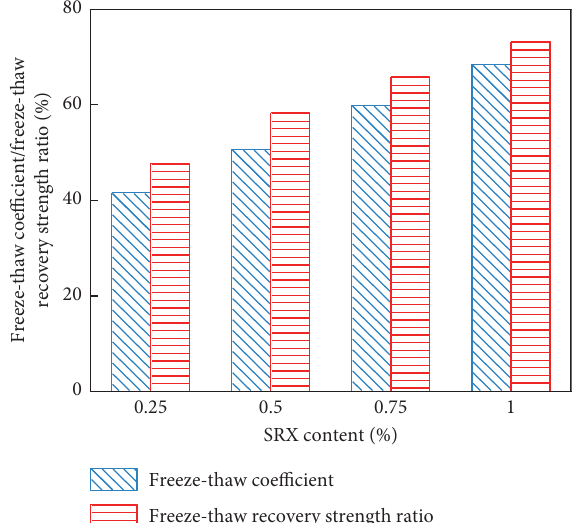
Figure 23: Freeze-thaw coefficient and freeze-thaw recovery strength ratio of different stabilizer